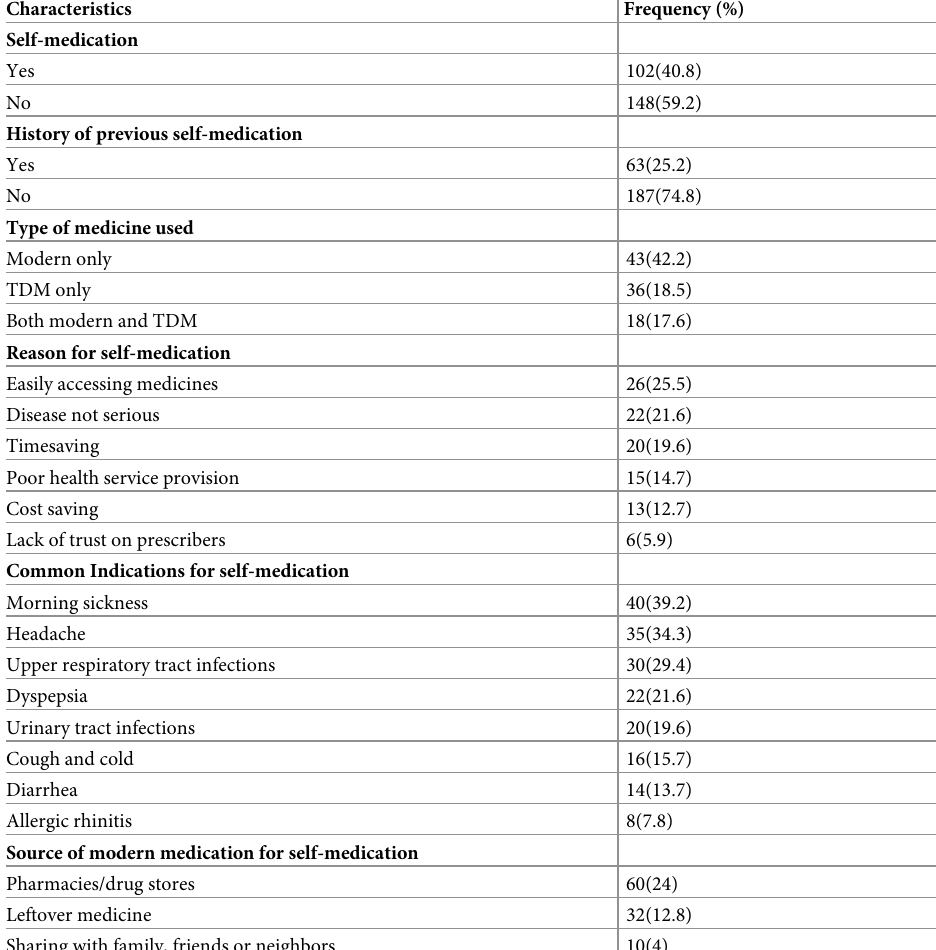
Table 3. Self-medication practice during pregnancy, 2019(n =